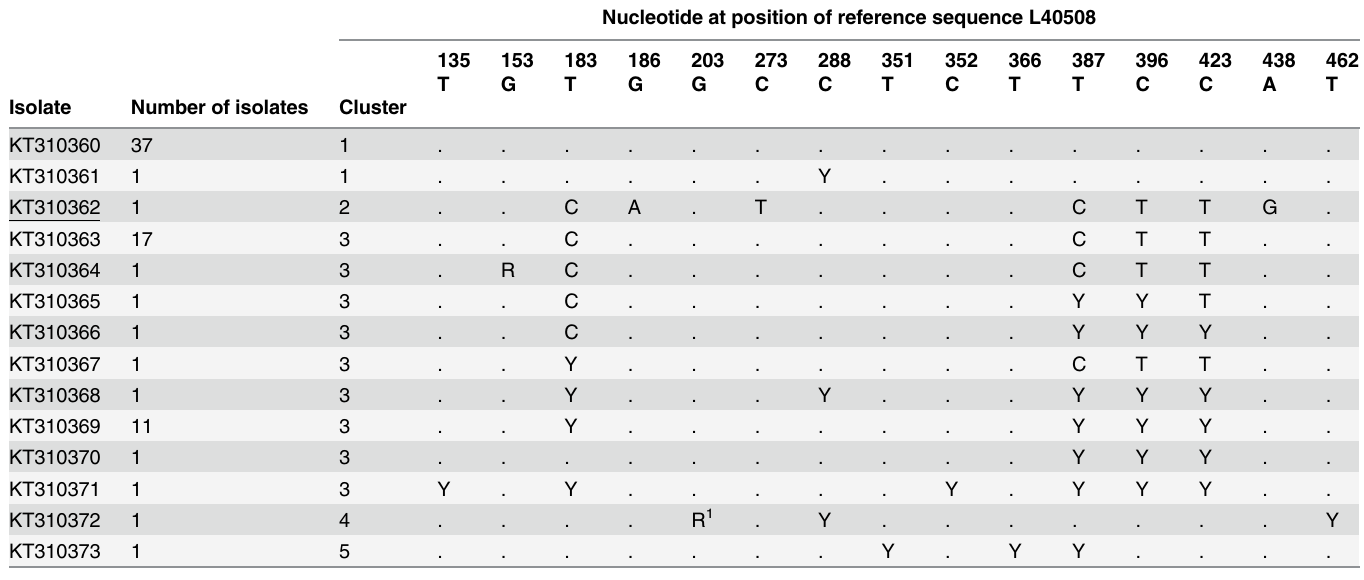
Table 5. Diversity and frequency of single-nucleotide polymorphisms displayed by Giardia duodenalis sub-assemblage BIV isolates at the gluta- mate dehydrogenase locus (partial sequence between positions 102 to 479) identified in the present study. Novel genotypes were shown underlined. Point mutations inducing amino acid substitutions were highlighted as superscript numbers indicating the amino acid